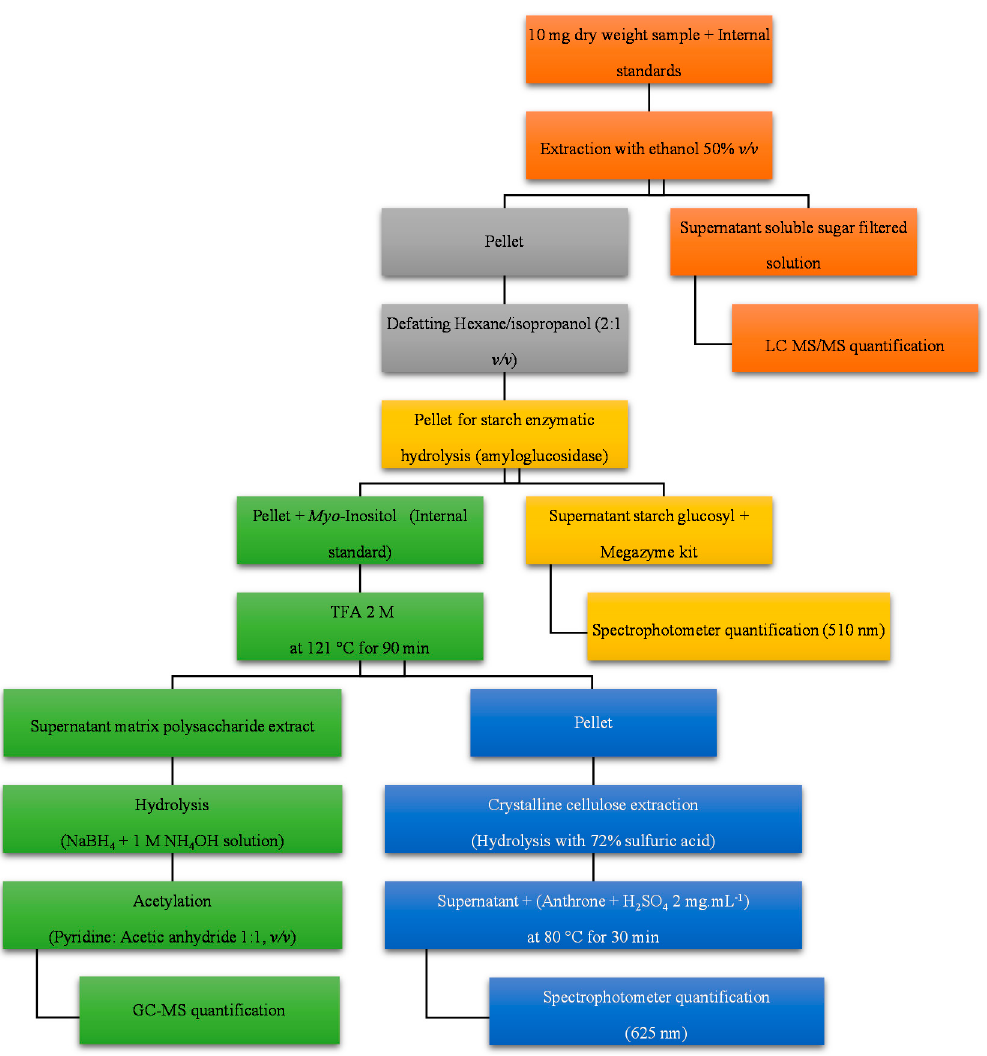
Figure 1. Scheme of the sequential carbohydrate extraction and quantification protocol. Each color refers to a specific part of the procedure. Soluble sugar and sugar alcohol extraction and quantification is shown in orange, oil removal in grey, starch extraction and quantification in yellow, hemicellulose extraction and quantification in green, and crystalline cellulose extraction and quantification in blue. Table 1. Sensitivity and linearity of LC–MS / MS quantification method for soluble sugars and sugar